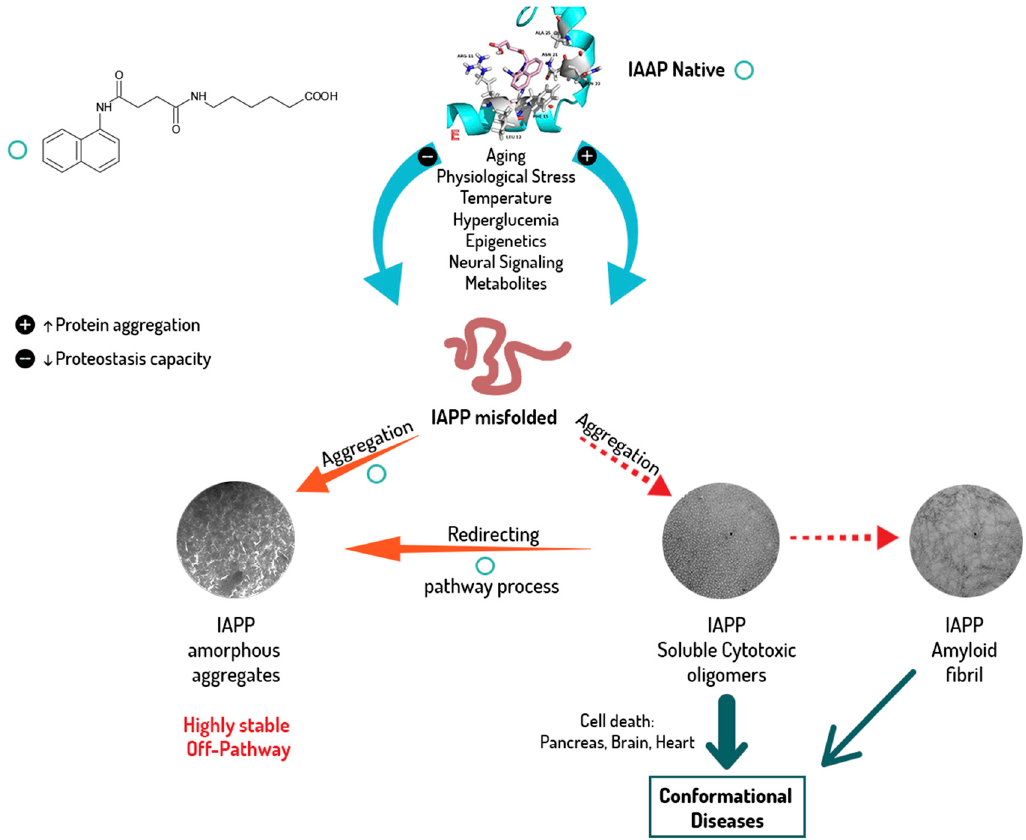
Figure 9. Proposal mechanism of pharmaco-chaperone E on protein aggregation/disaggregation. Pharmaco-chaperone E can regulate fibre formation processes by binding to the native state, minimizing the formation of IAPP misfolded and cytotoxic oligomers, and in the case of existing IAPP misfolded and cytotoxic oligomers, redirecting the pathway process. Furthermore, it interacts with the amylin fibres and avoids their growth and propagation.